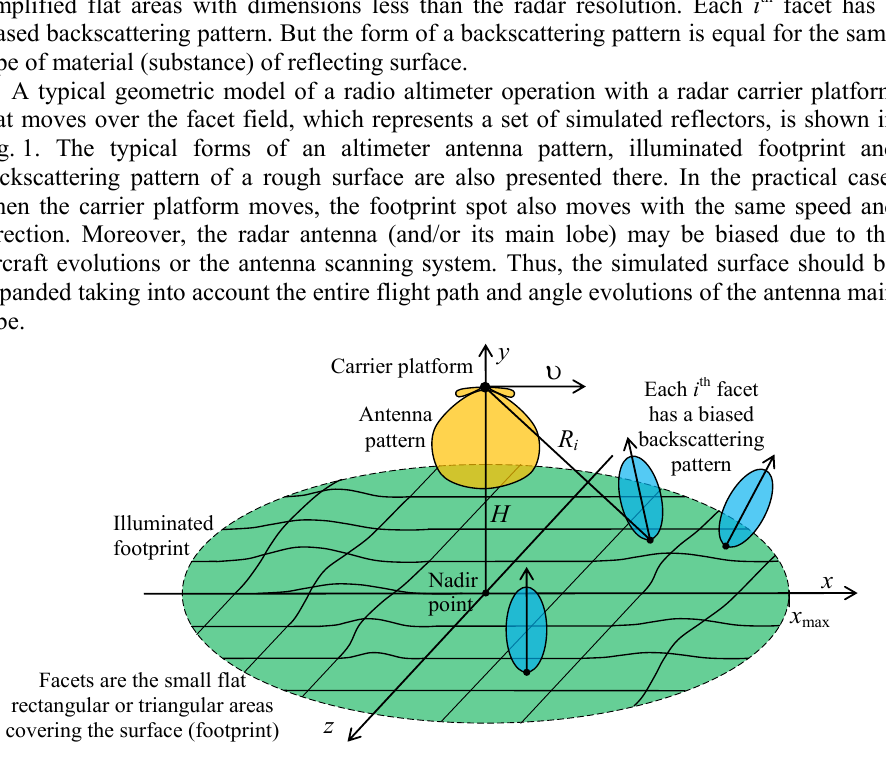
Fig. 1. Radar scene with facet field for modeling reflectons from the underlying